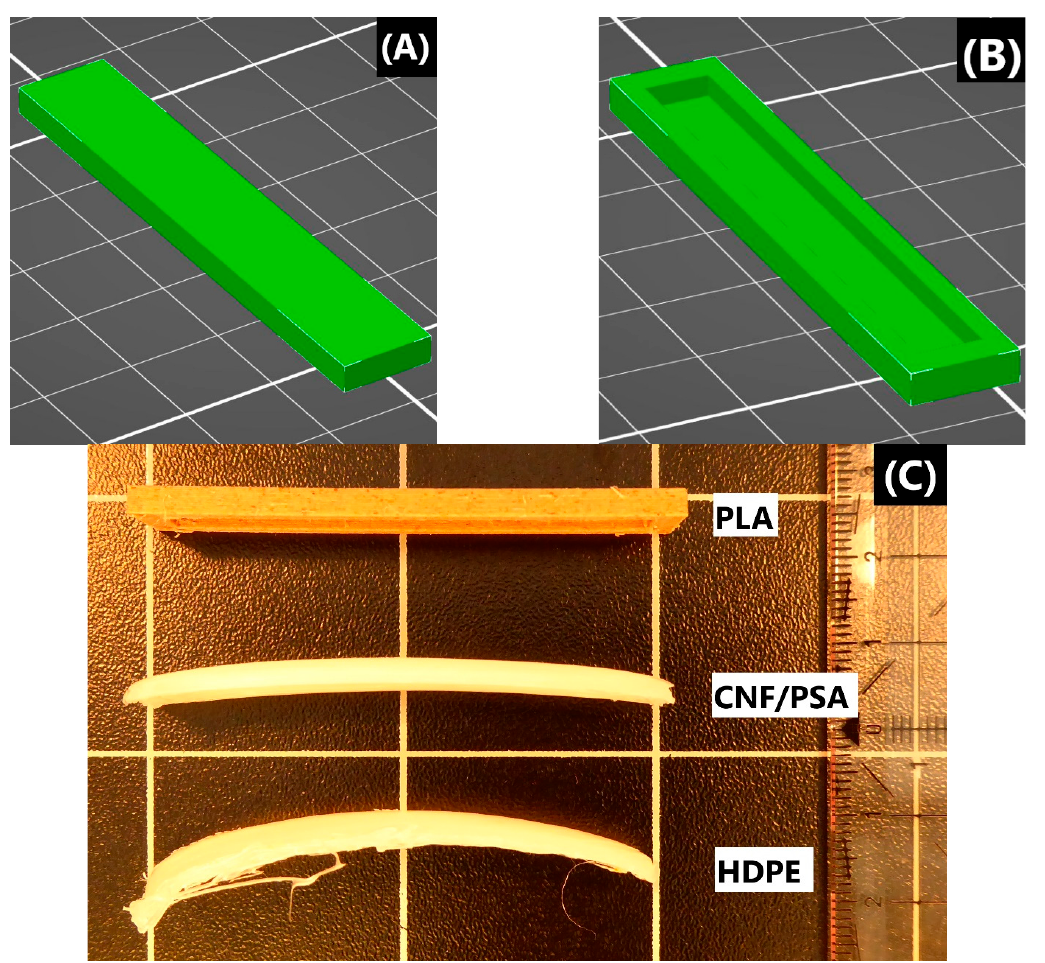
Figure 8. Three-dimensional models of full ( A ) and notched ( B ) designs; ( C ) is a representative photo of printed notched models.